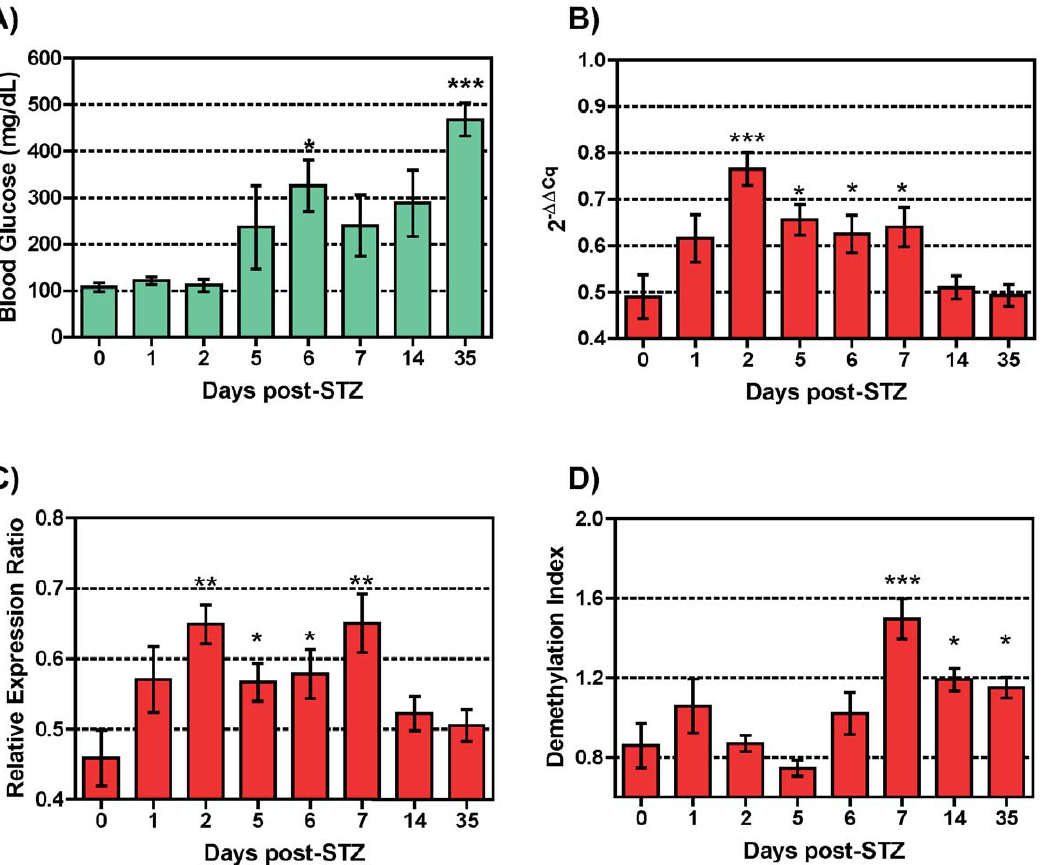
Figure 5. Quantification of circulating beta cell DNA in STZ-treated diabetic mice. NOD/scid mice were injected with STZ at days 0, 1, and 2, and blood was collected pre-treatment and post-treatment days 1, 2, 3, 5, 6, 7, 14, and 35. A) Blood glucose levels for untreated (n=3) and STZ-